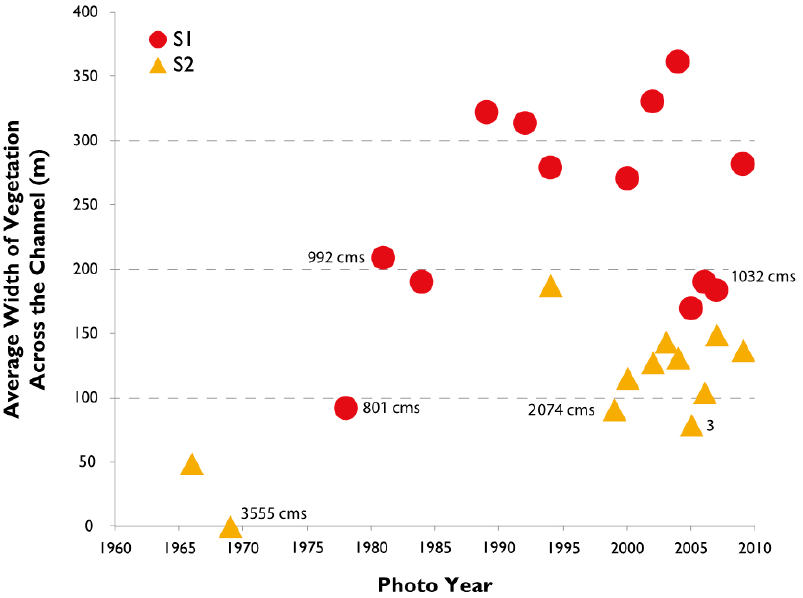
Figure 9. Average vegetation width over time for sites S1 and S2. Selected flood discharges are shown.